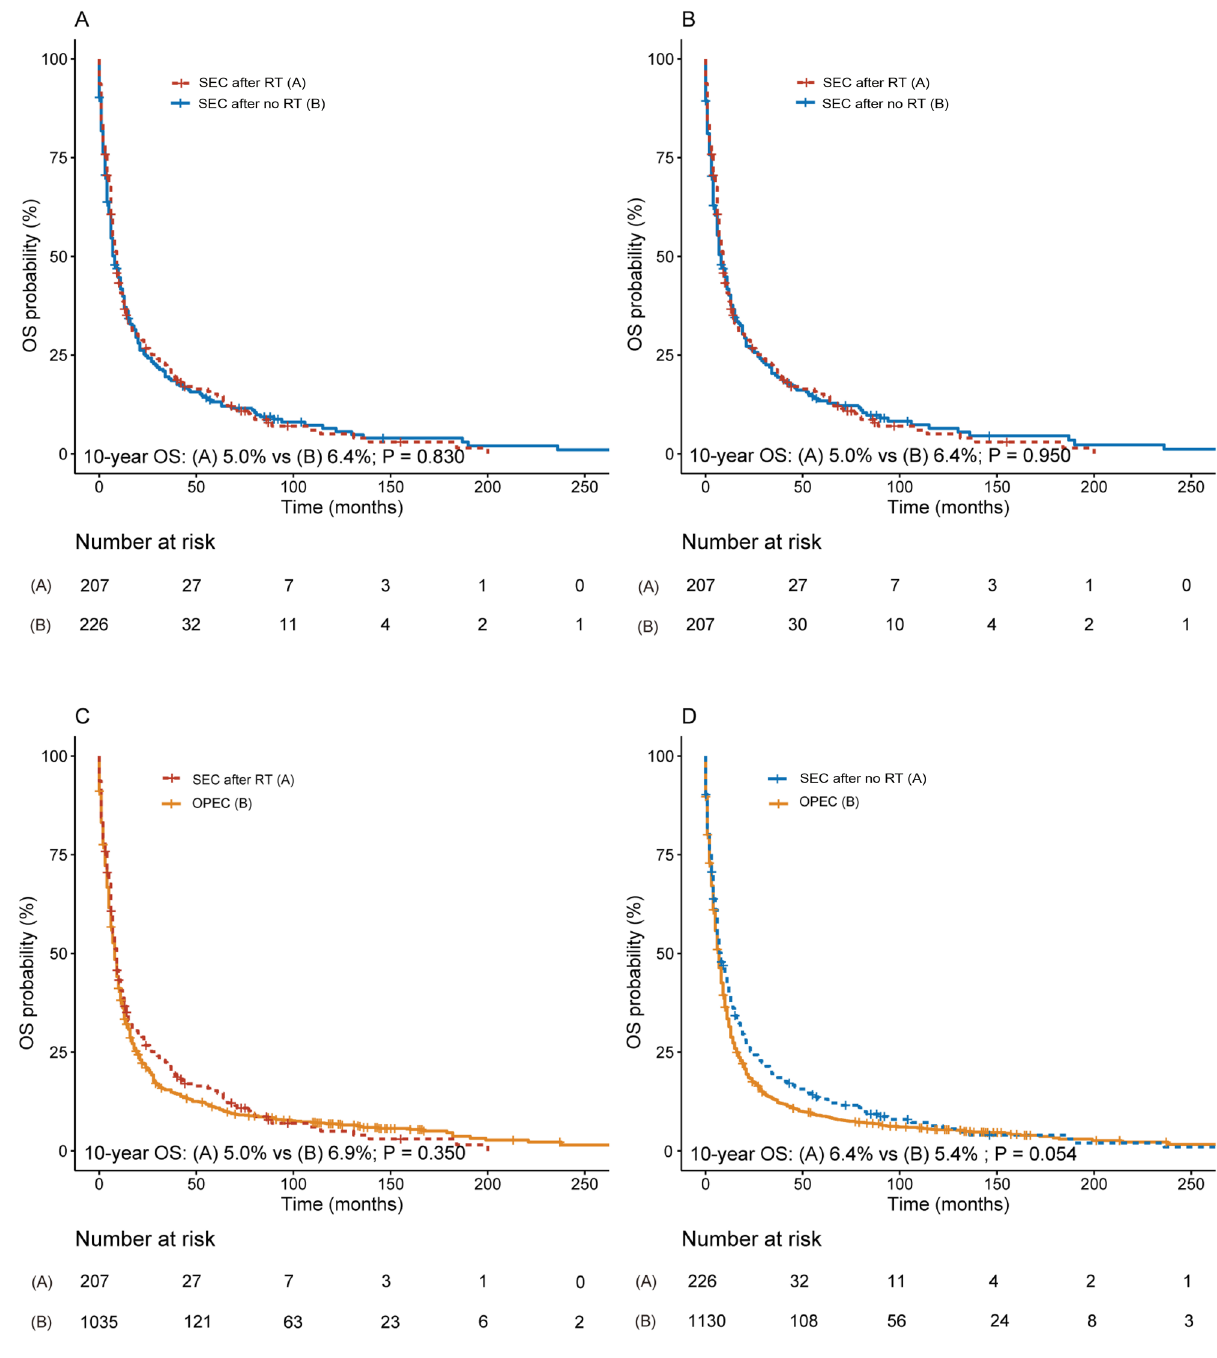
Figure 3. ( A ) Survival comparison between breast cancer (BC) patients who developed secondary esophageal cancer(SEC) after radiation therapy (RT) and BC patients who developed SEC after no RT (before PSM); ( B ) survival comparison between BC patients who developed SEC after RT and BC patients who developed BC after no RT(after PSM); ( C ) survival comparison between BC patients who developed SEC after RT and patients with only primary esophageal cancer (OPEC); ( D ) Survival comparison between BC patients who developed SEC after no RT and patients with OPEC. ( B ) PSM matched BC patients who developed SEC after RT and BC patients who developed SEC after no RT at a 1:1 ratio. SEC patients with RT ( C ) and without RT ( D ) were matched with OPEC patients based on propensity scores at a ratio of 1:5, and survival analysis was performed. The variables that were matched for PSM were age at SEC diagnosis, year of SEC diagnosis, race, SEC stage, and type of SEC treatment. The Supplementary Data reveal the complete patient characteristics of OPEC before and after PSM. RT radiation therapy; no RT no radiation therapy; SEC secondary esophageal cancer; OPEC only primary esophageal cancer; OS overall